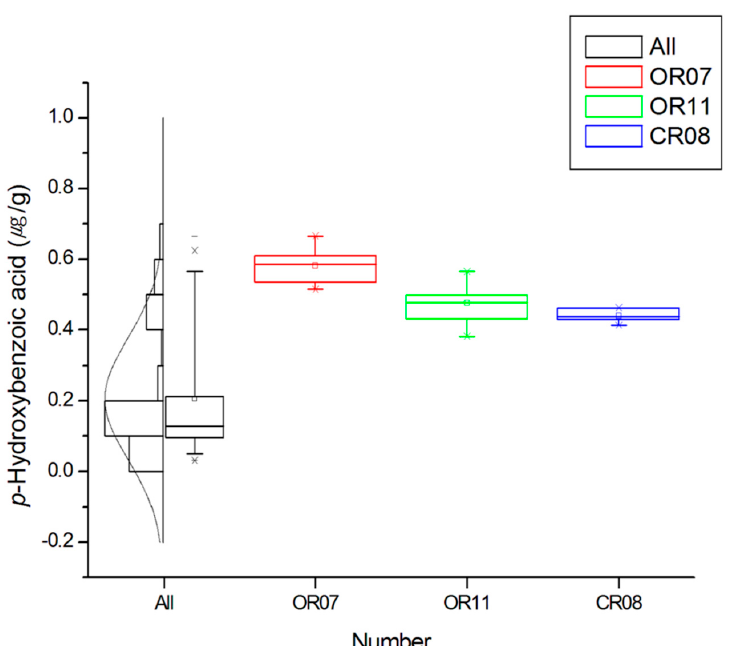
Figure 6. Boxplot, histogram, and distribution curve for the p -hydroxybenzoic acid content and for specific samples. Each box corresponds to the interquartile range containing the middle 50% of data. Whiskers indicate the highest and lowest values (95% and 5%, respectively) in the entire data range. The solid square within the box represents the mean value. The line across the box represents the median value.